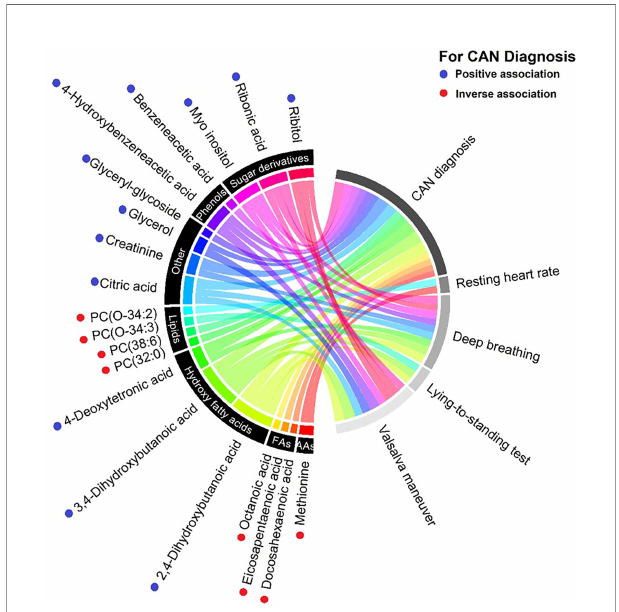
FIGURE 1 | Chord diagram of the detected associations between metabolites (left) and the cardiovascular autonomic neuropathy (CAN) diagnosis and speci fi c CAN measures (right) from the crude(udadjusted) model. Metabolites are categorized into pathways and shown with unique colors. Line width indicate strenght of the respective assocation. PC, Phosphatidylcholines; FAs, Fatty acids; AAs, Amino acids. Blue dots indicate higher levels of oucomes in patients with CAN compared with no CAN. Red dots indicate lower levels of outcomes in patients with CAN compared with no CAN.